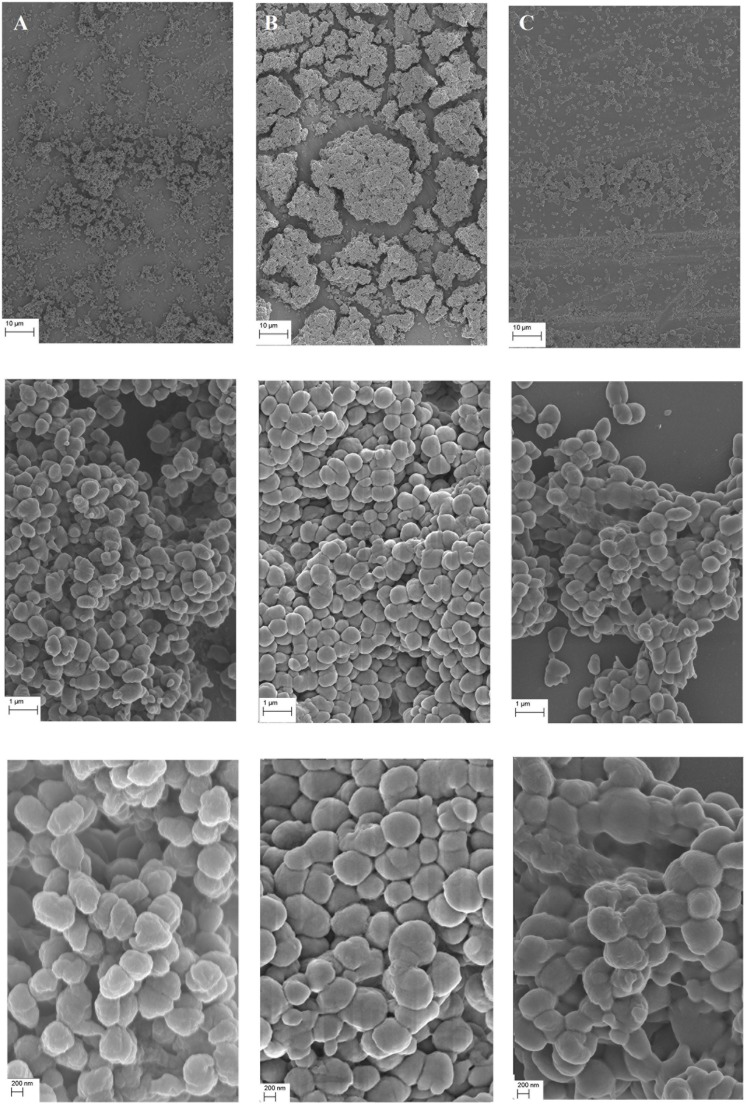
Biofilm produced by N. gonorrhoeae on cover glass after 24 h visualized by Field Emission Scanning Electron Microscopy. (A) Biofilm formed by the wt FA1090 strain; (B) Biofilm formed by the N. gonorrhoeae ngoAXmod::km mutant and (C) Biofilm formed by the N. gonorrhoeae igatrpb::ngoAXmod mutant. Experiments were triplicated and representative photographs are shown.